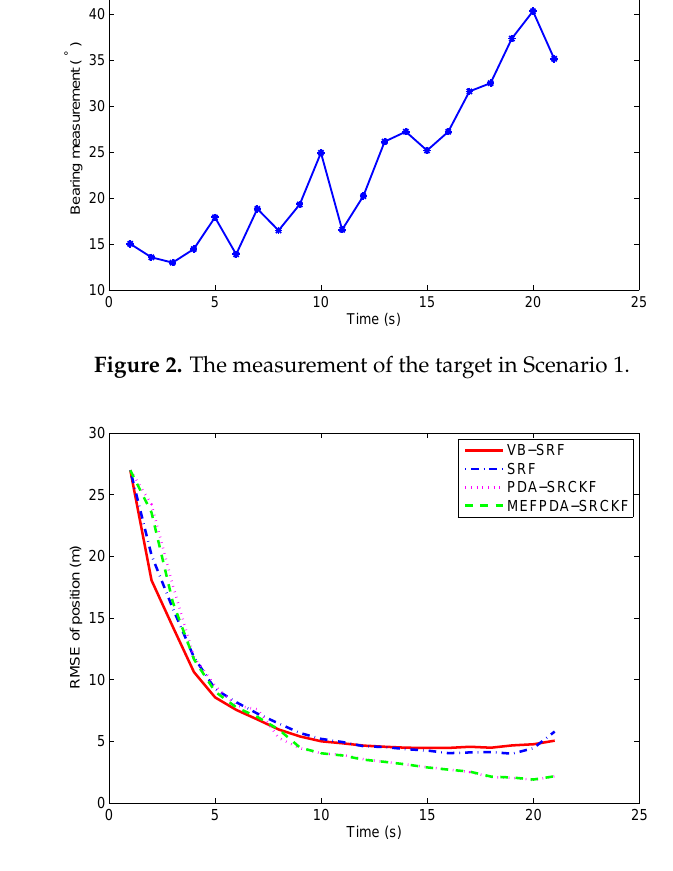
Figure 3. RMS target position errors with correct clutter probability in Scenario